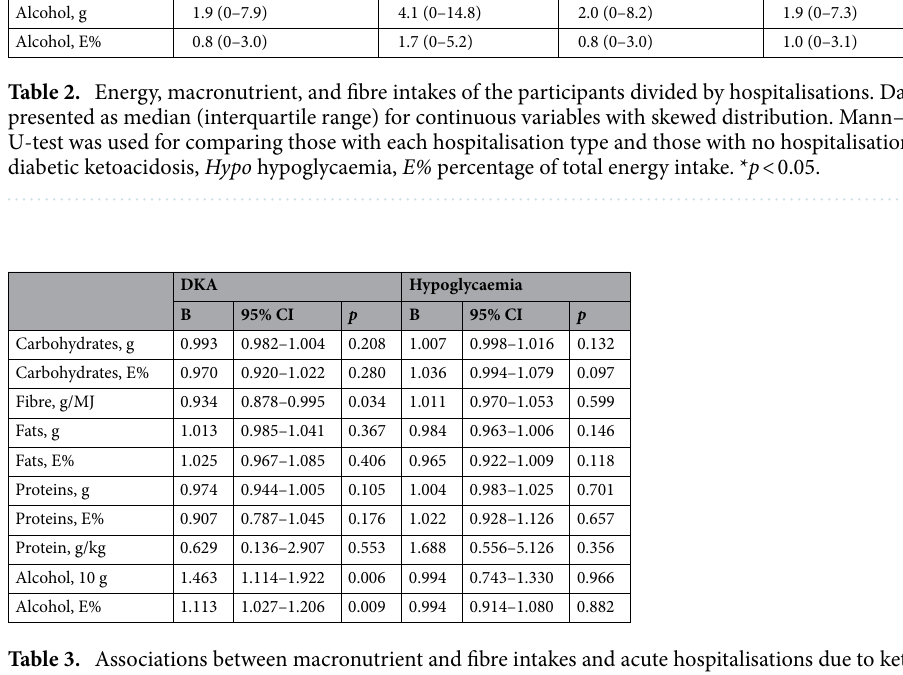
Table 3. Associations between macronutrient and fibre intakes and acute hospitalisations due to ketoacidosis and hypoglycaemia. Logistic regression analysis. Models are adjusted for age, sex, insulin dosing per weight in kg, physical activity, and total energy intake. DKA diabetic ketoacidosis, E% percentage of total energy intake.